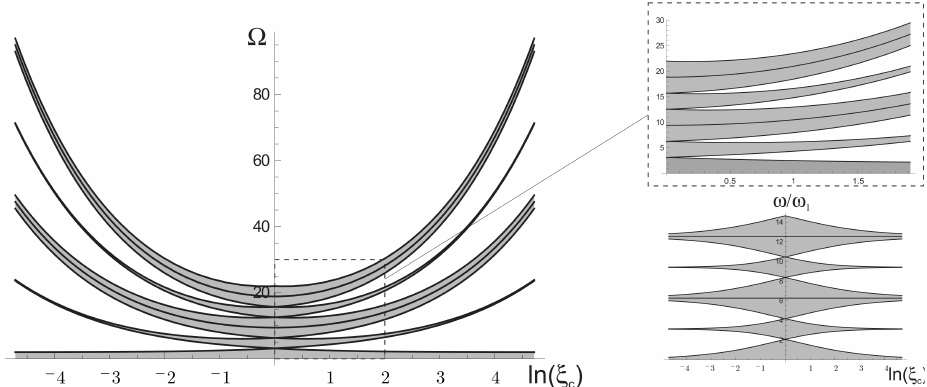
Figure 5. Continuous laminate. Band distribution as a function of the impedance ratio ξ c . Normalised frequency Ω is given for the characteristic frequency ratio η c = 0.5. In the upper right, a detail of the band distribution is given. On the bottom right, the same results are presented in term of ω / ω 1 . Filled area indicates propagating